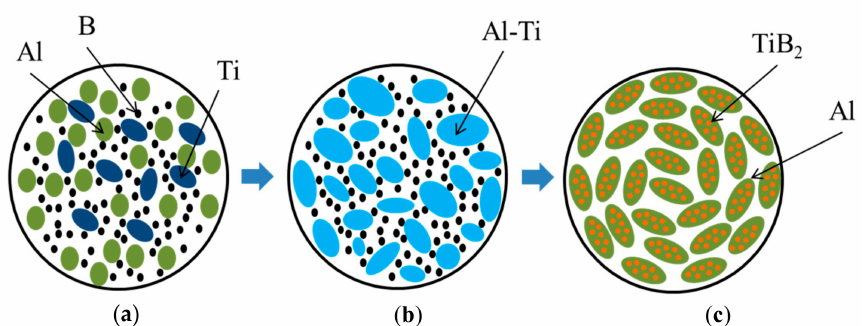
Figure 13. Schematic of structure formation in Al-TiB 2 -Al 3 Ti composite: ( a ) initial powder mixture; ( b ) melting of Al particles and melt distribution between Ti and B particles; ( c ) combustion